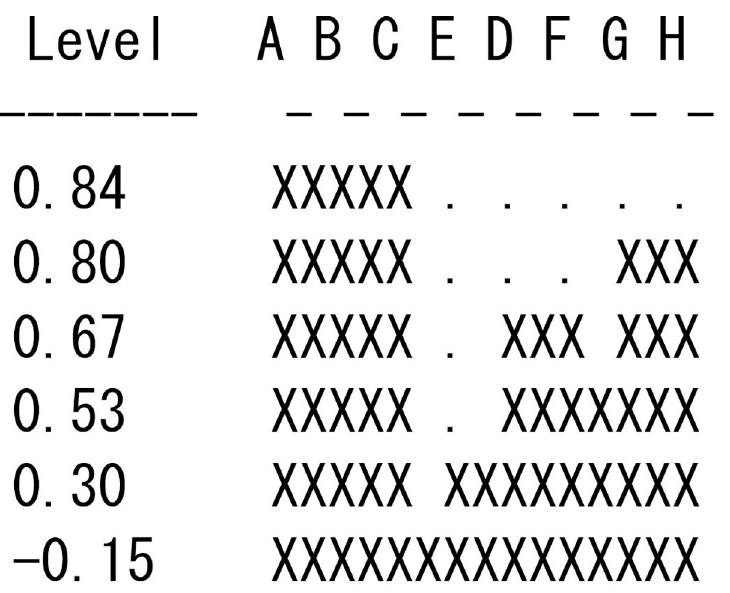
Fig 3. Results of a hierarchical cluster analysis of the hypothetical